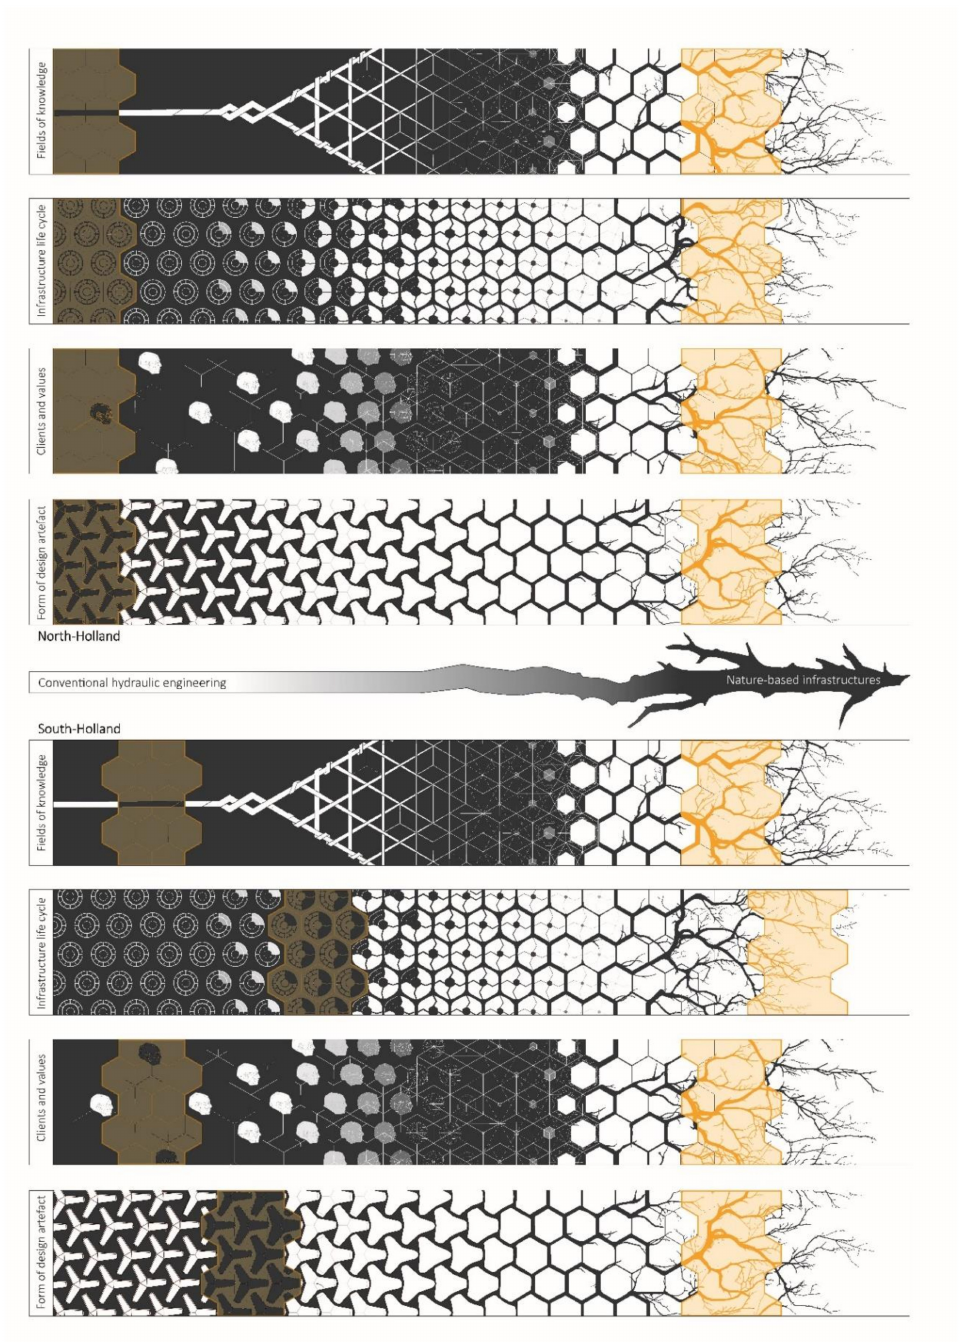
Figure 2. The metamorphosis in hydraulic engineering represented by the two examples of old infrastructures (brown) and new infrastructures (yellow) on the coasts of North Holland ( top ) and South Holland ( bottom ). The degree of adoption of a Building with Nature approach is characterized in terms of four continua: (i) fields of knowledge, (ii) infrastructure life cycle, (iii) clients and values, and (iv) form of the design artefact. A shift can be observed from more conventional hydraulic engineering designs marked in brown and located towards the left-hand side to nature-based infrastructures marked in yellow and located towards the right-hand